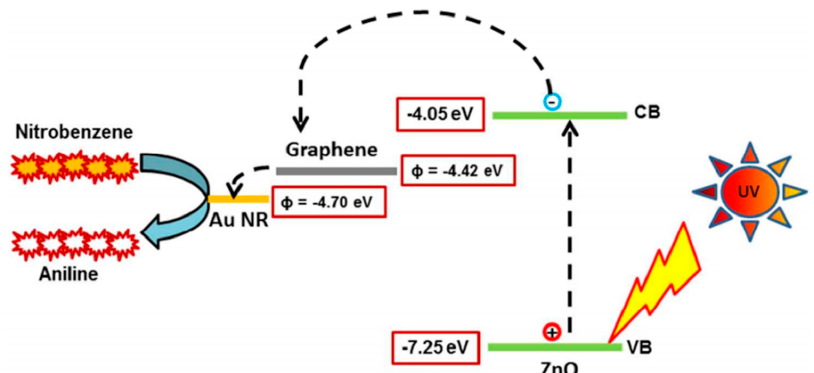
Figure 2. Schematic illustration of energy band diagram and a proposed mechanism of the charge carrier transitions in G–ZnO–Au composite towards photocatalytic nitrobenzene degradation under UV light irradiation.